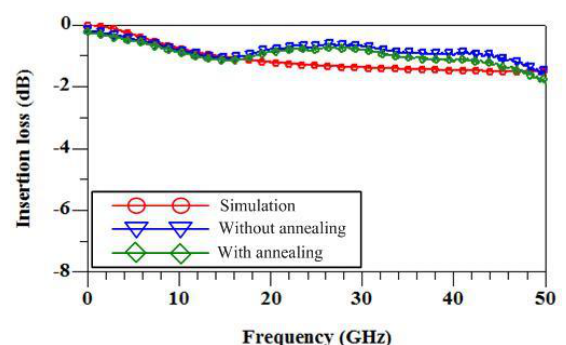
Figure 6. Insertion loss of the RF